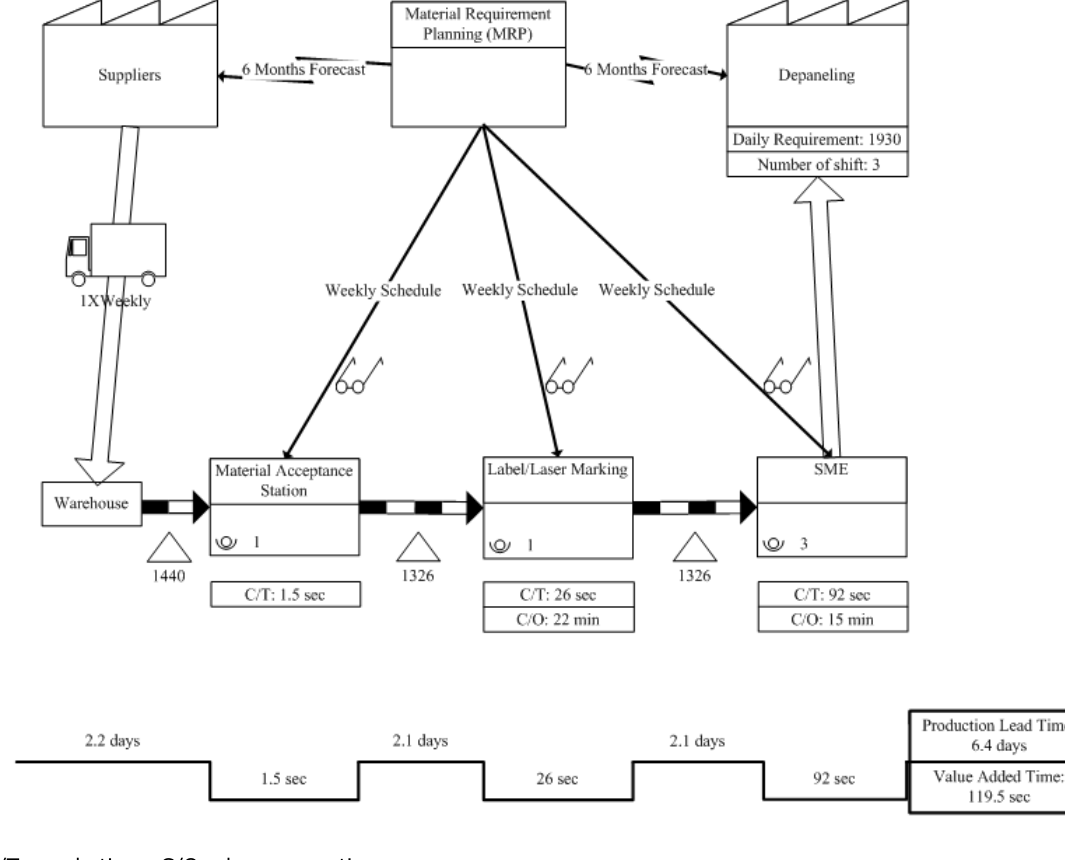
Figure 2. Current-state